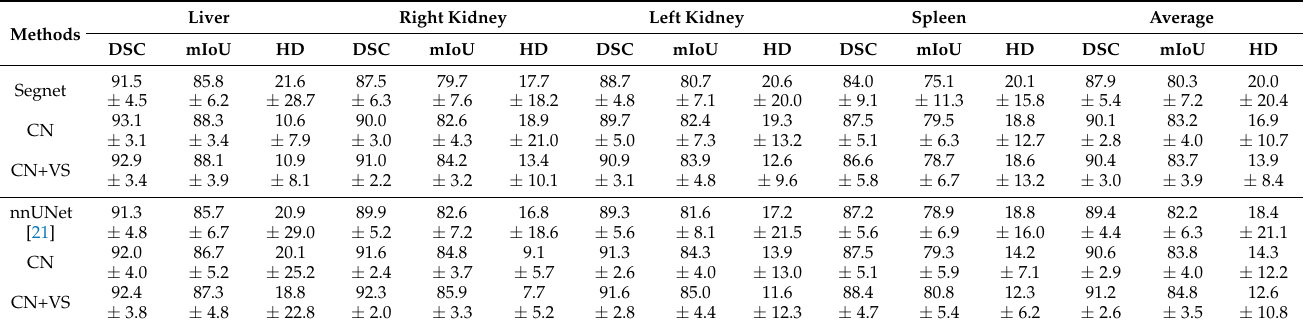
Data are presented as mean ± standard